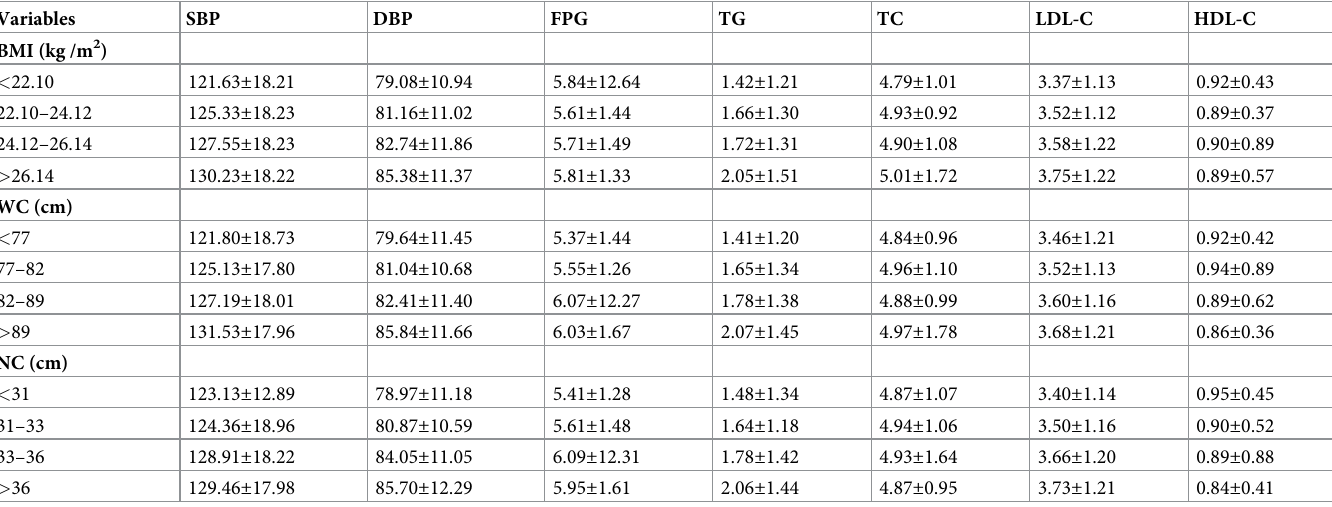
Table 2. The distribution of blood pressure, plasma glucose and blood lipid levels among different BMI and WC (Mean ± SD).